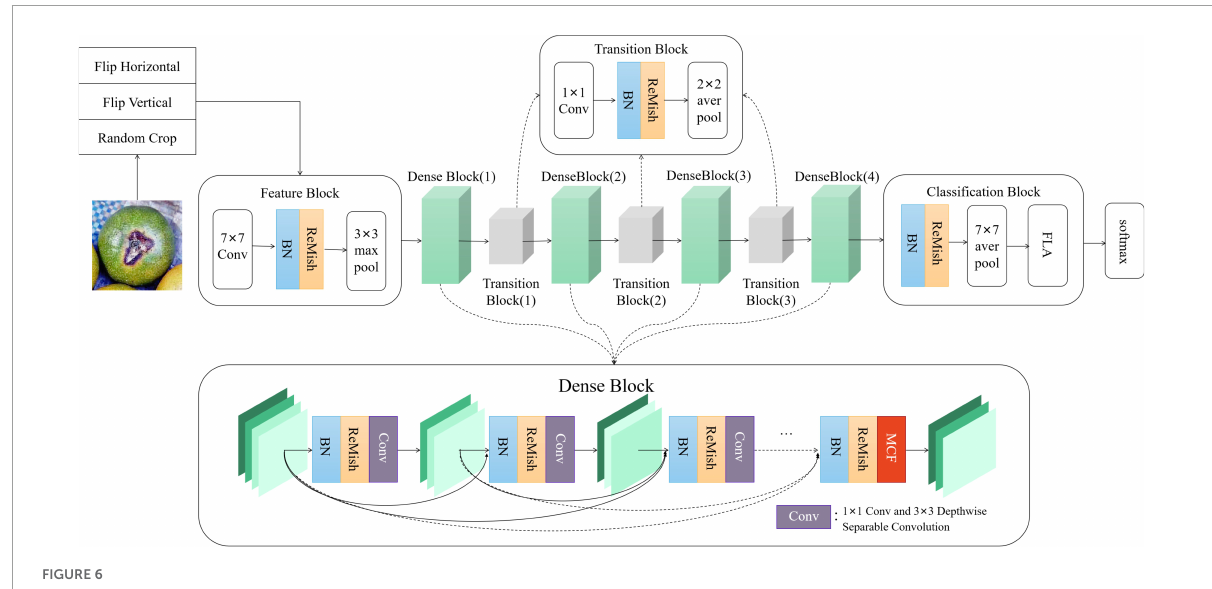
FIGURE6 DS-MENet network structure.